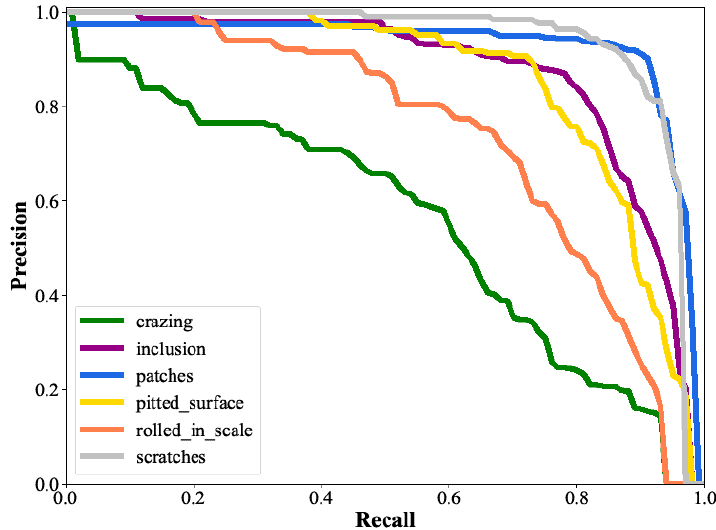
Figure 7. The PR curves for six defect types.